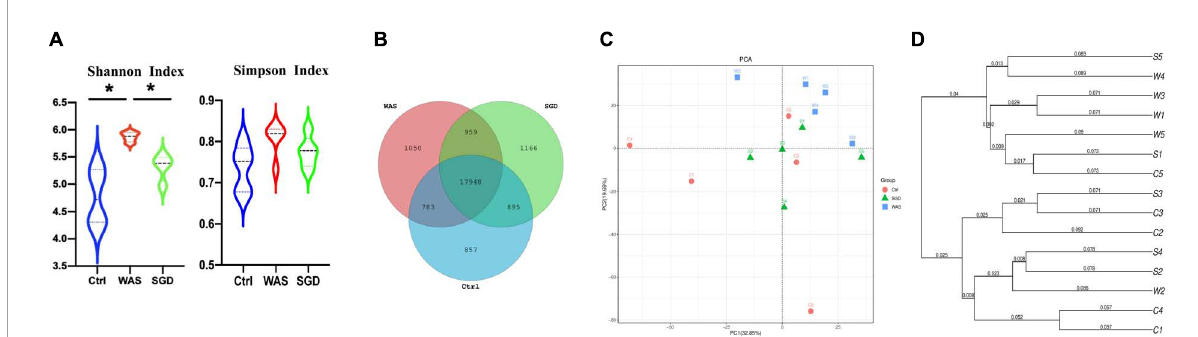
FIGURE2 Effects of SGD on the intestinal microbiota of IBS-D model rats. (A) Shannon index and Simpson index were calculated after refining to an equal number of sequence reads for all samples. The Shannon index of the WAS group was higher than that of the control and SGD groups, while Simpson index has no significant difference among the three groups. (B) Venn diagram represented OTUs in each group. (C) PCA scores based on the weighted Unifrac index were different among groups. (D) The weighted Unifrac index based PCA score phylogenetic tree of gut microbiota. Control group; WAS group; SGD group ( n = 5 per group) (* P < 0.05).